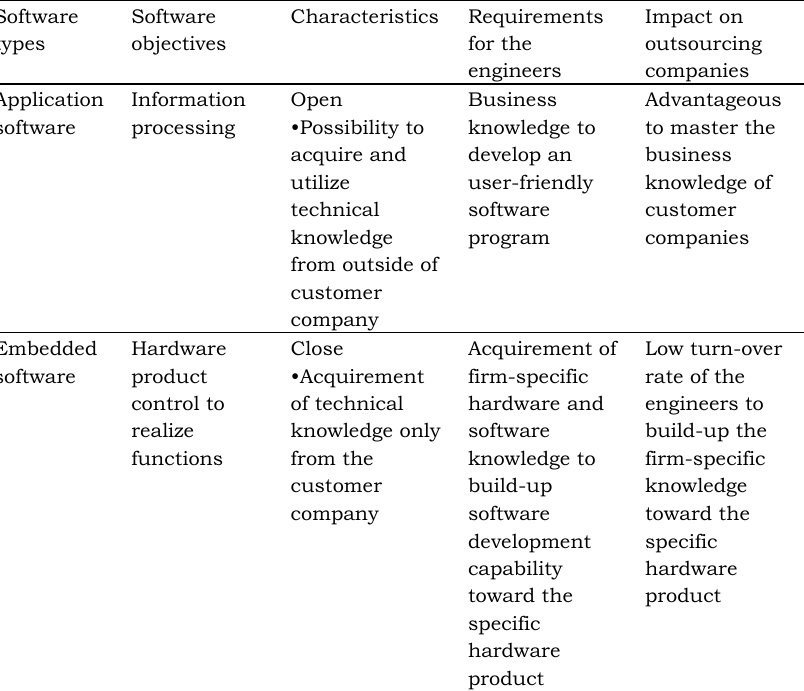
Table 2. Software types and requirements for the engineers